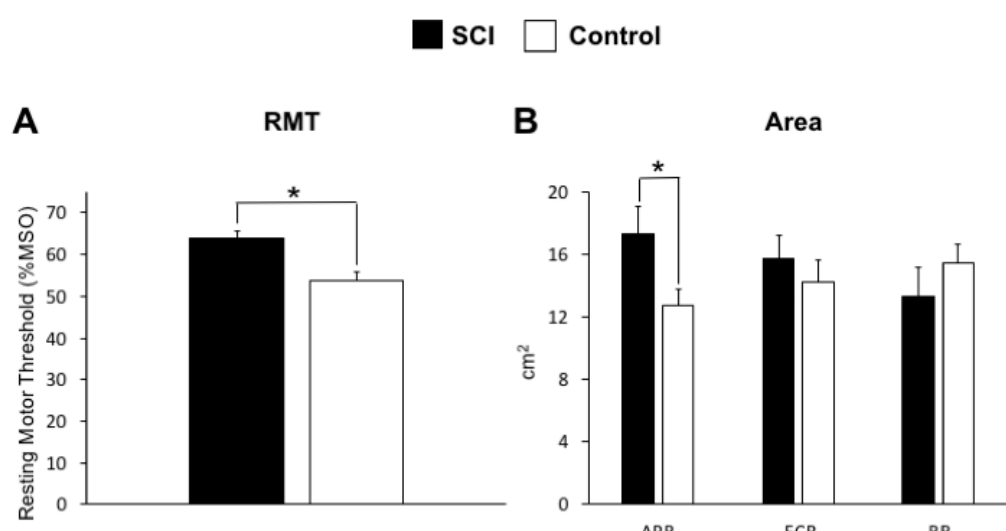
Figure 4. ( A ) The main effect of GROUP revealed that the SCI group had larger higher resting motor threshold (RMT) % maximum stimulator output (MSO) values in the relative to controls ( p = 0.0289). ( B ) The abductor pollicis brevis (APB) muscles demonstrate larger map areas (defined as the number of active grid points) in the SCI group relative to controls ( p = 0.030). * indicates a significant difference between groups.